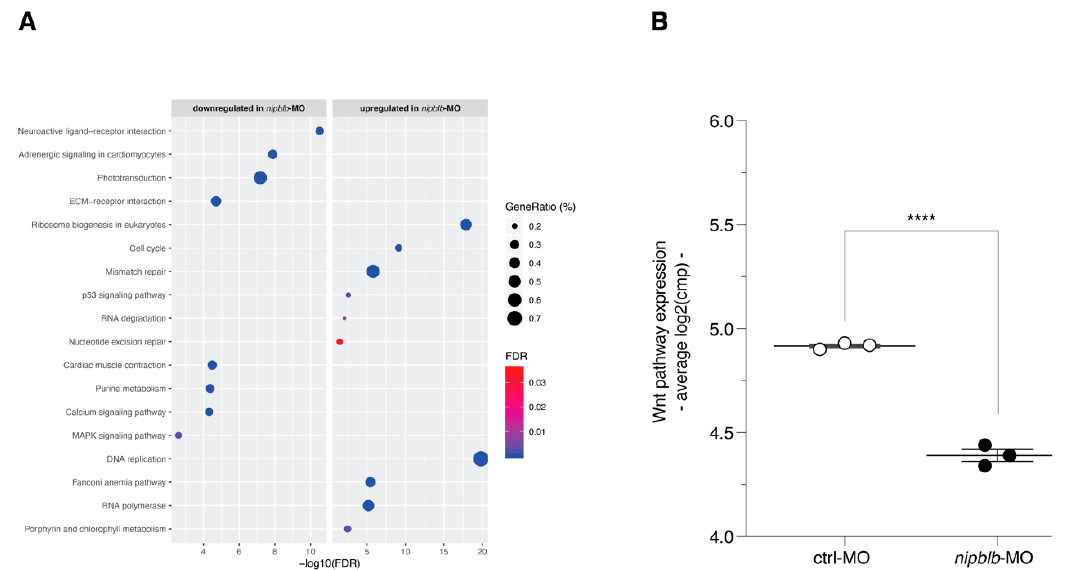
Figure 3. ( A ) Dot plot of the KEGG gene sets significantly enriched in the 3972 down-regulated (left) and in the 1366 up-regulated (right) genes by nipblb loss-of-function at 24 hpf. Dot color indicates statistical significance of the enrichment (false discovery rate FDR); dot size represents the fraction of genes annotated to each term. Gene sets are ranked in decreasing order based on the FDR value. ( B ) Average expression of KEGG Wnt canonical pathway genes in sample subgroups (**** p ≤ 0.0001 in unpaired t -test).